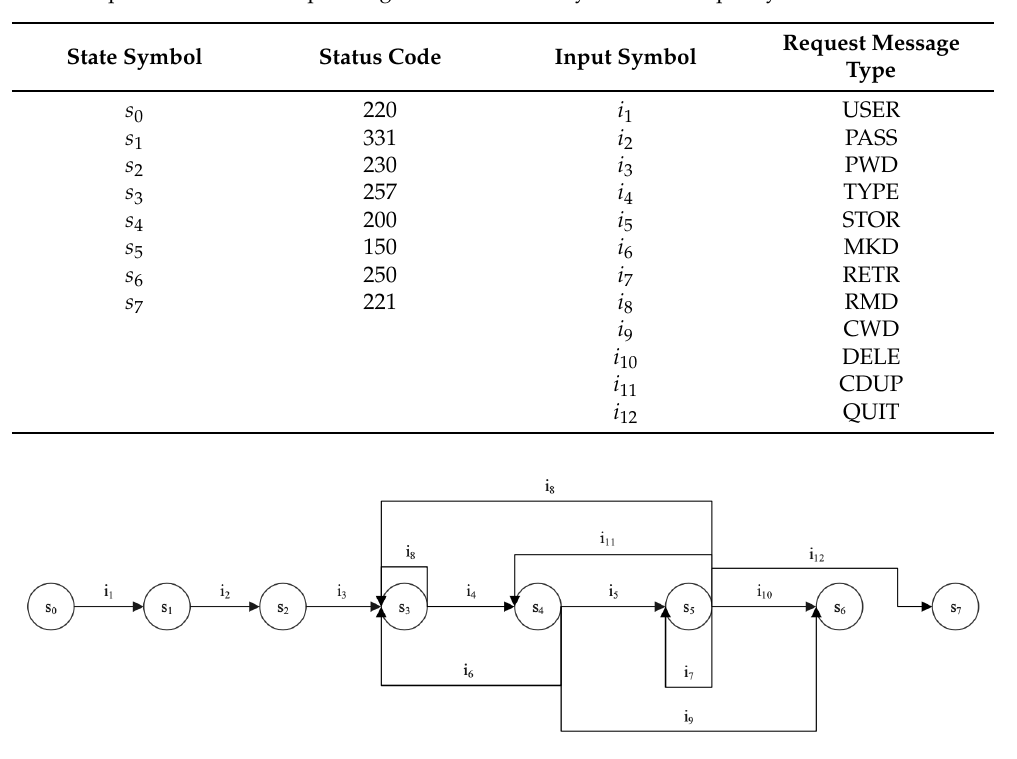
Table 1. Specific values corresponding to different state symbols and input symbols.